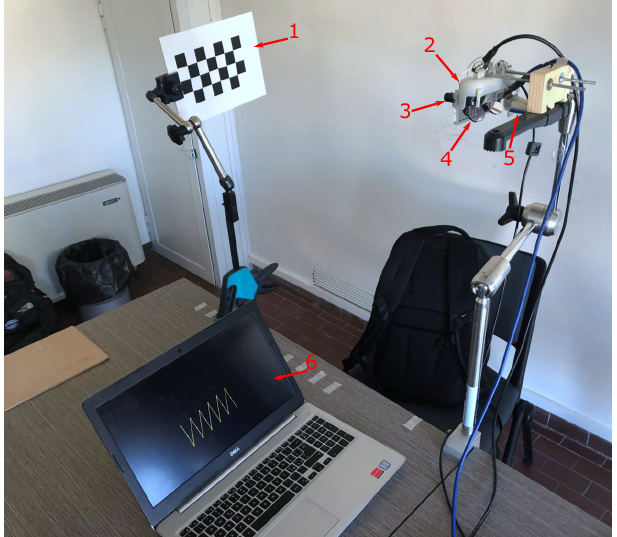
Figure 5. Experimental environment. 1 → Validation checkerboard. 2 → Optical see-through head mounted display. 3 → Tracking camera. 4 → Optical combiner. 5 → 3D printed mounting template with the embedded viewpoint camera. 6 → Laptop where the calibration routines and the AR application